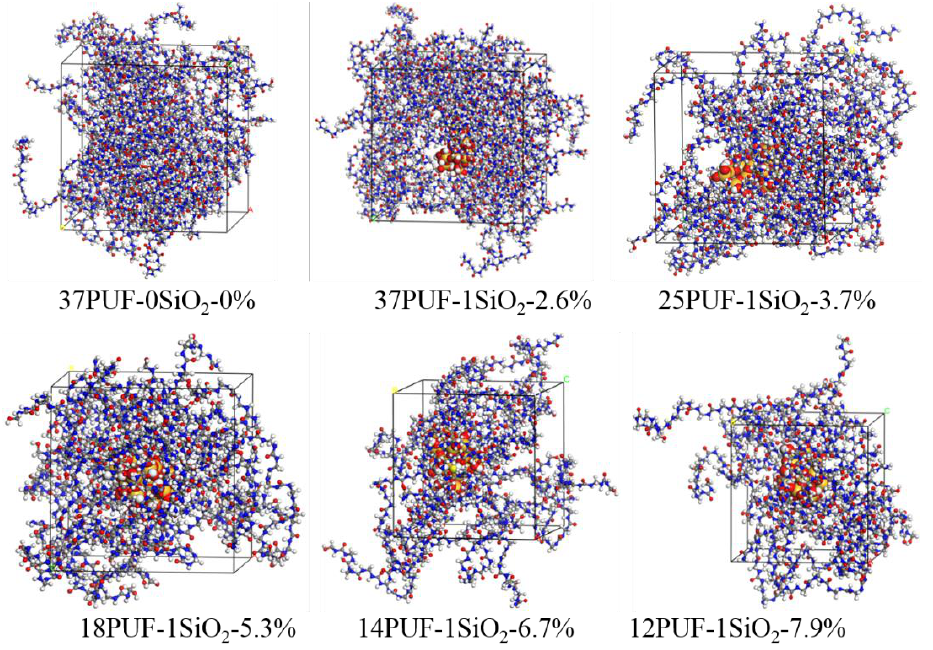
Figure 7. The final equilibrium PUF-SiO 2 models. Table 1. The cell parameters of PUF-SiO 2 models (mean ± standard error).